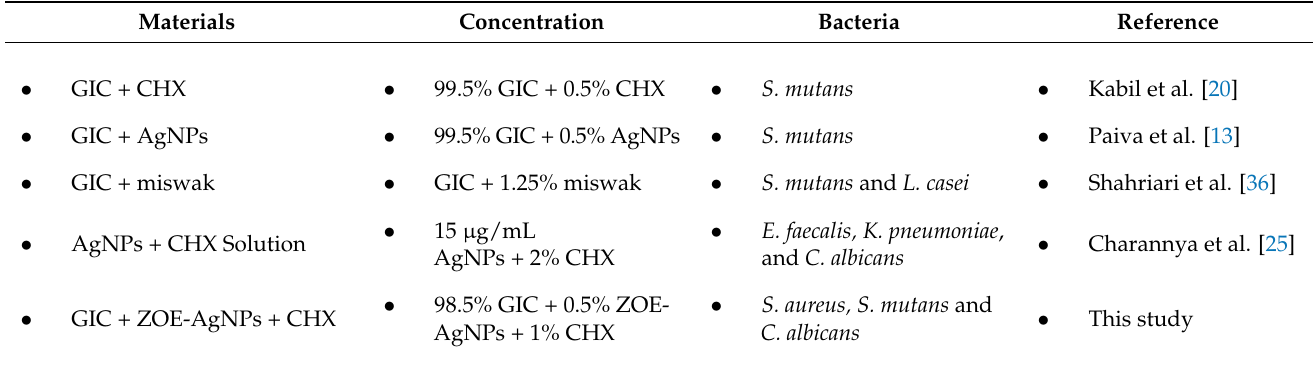
Table 2. Comparison of earlier research with restorative materials for antibacterial activity against oral